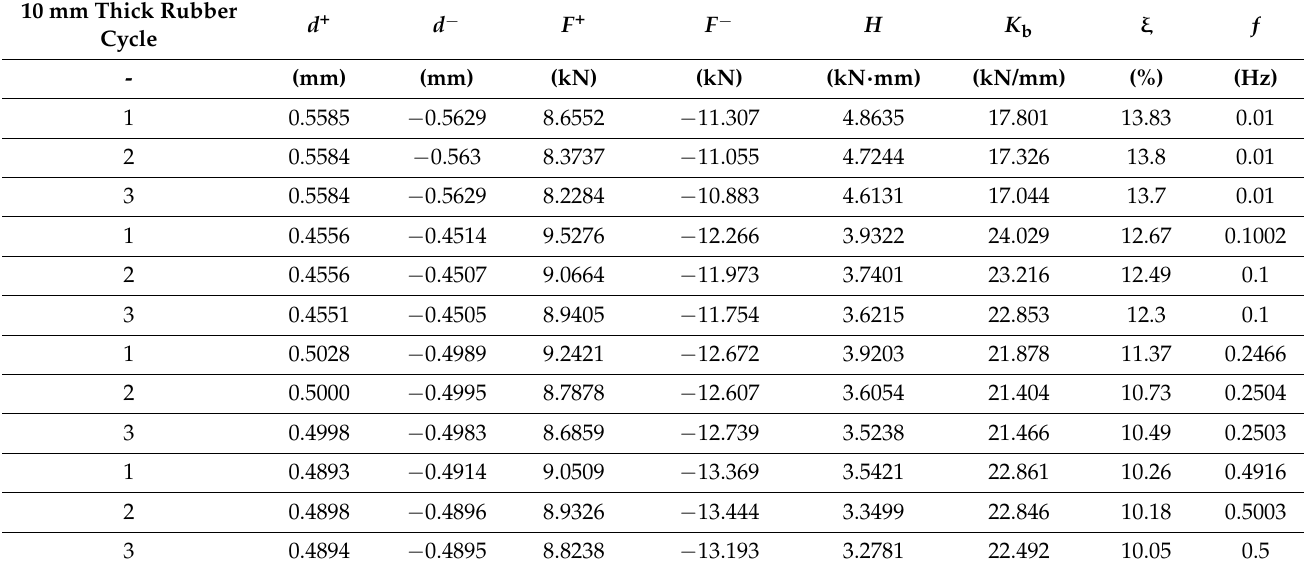
Figure 10. Plot of device testing, showing force–displacement for 10 mm thick HDR material at different frequencies. Table 6. Result data for 10 mm thick HDR material at different frequencies.